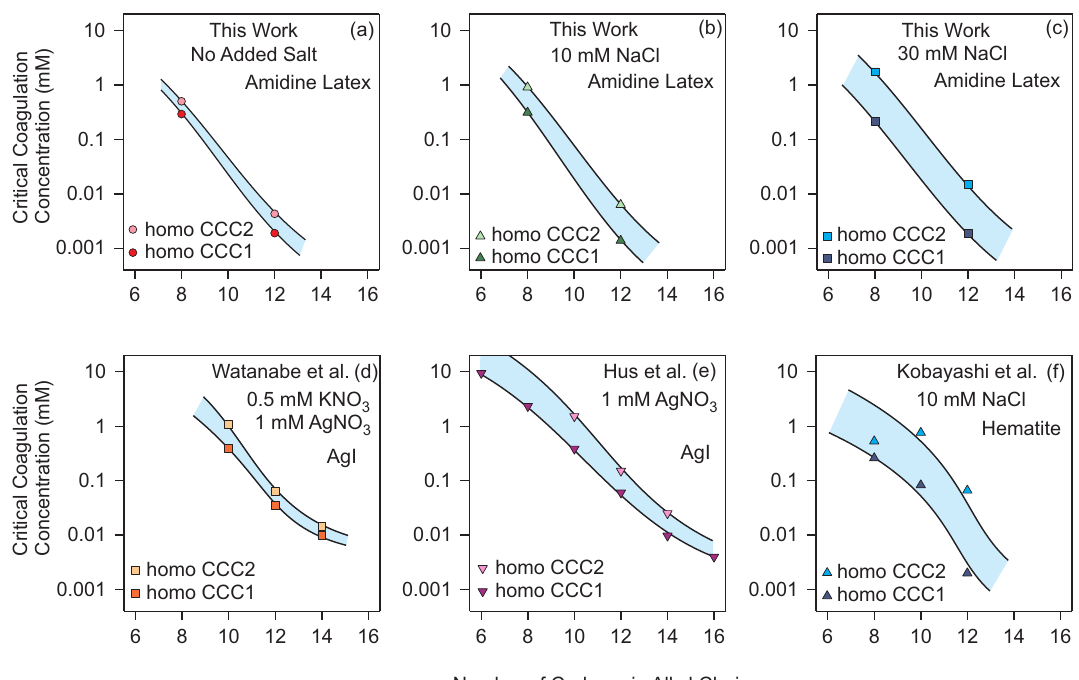
Figure 8. Critical coagulation concentration as a function of the chain length of alkyl sulfate surfactant. Homo-CCC1 and homo-CCC2 for amidine latex used in this work with ( a ) no added salt, ( b ) 10 mM, and ( c ) 30 mM salt. AgI particles by ( d ) Watanabe [13] and ( e ) Hus et al. [14], and ( f ) hematite by Kobayashi et al. [15]. The CCCs shown in ( e ) were extracted from the maxima of turbidity curves given in [14]. The lines serve only as eye-guides. The colored area between the CCCs marks the region of fast